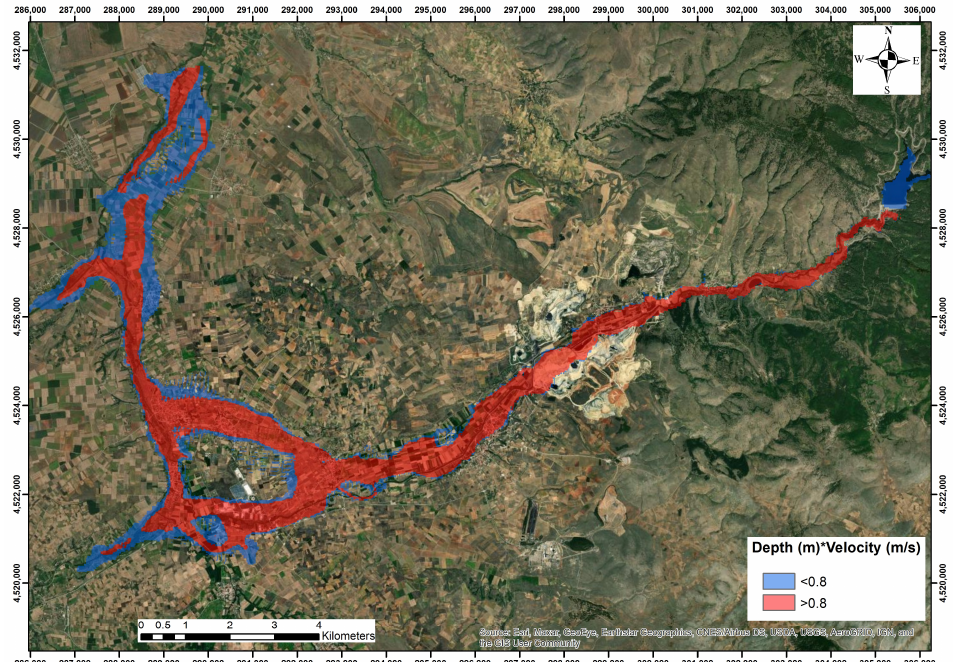
Figure 19. Flood hazard maps for the overtopping dam failure scenario (second classification ap- proach).